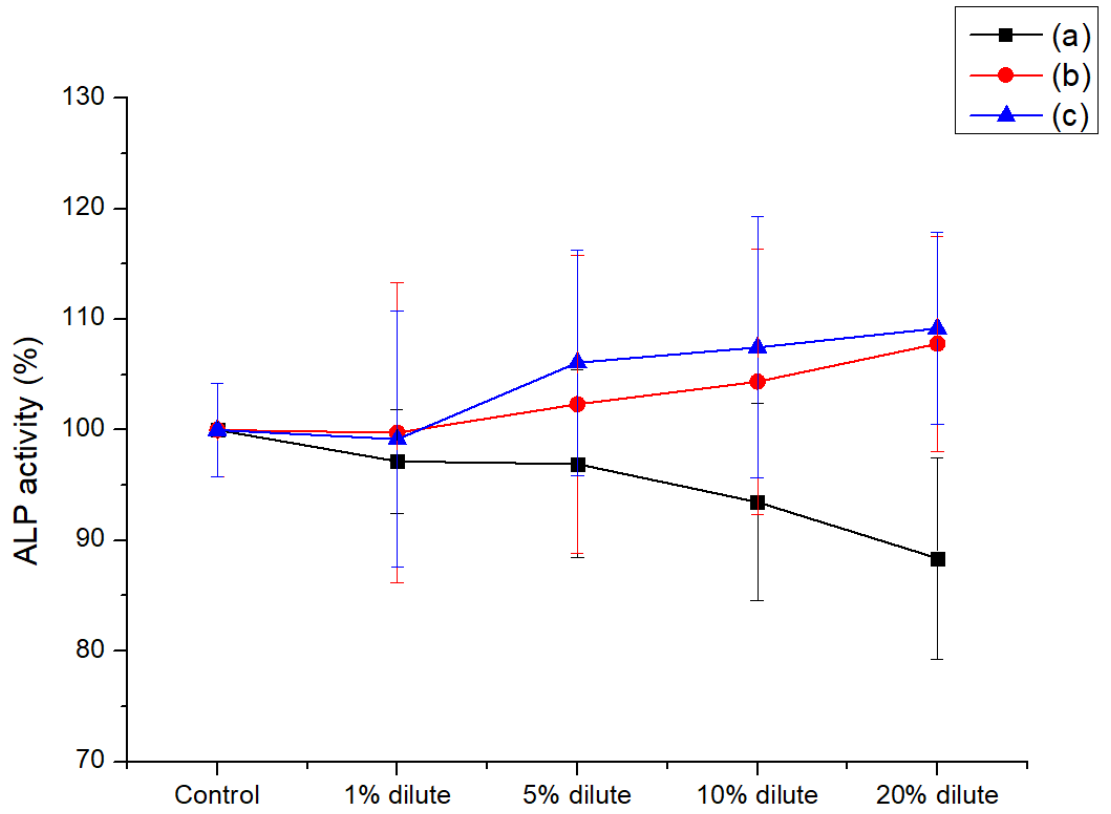
Figure 5. Cell activity results of PEEK composites via the ALP assay; ( a ) neat PEEK, ( b ) H2C1 (SUS), ( c ) H2C1 (MF).